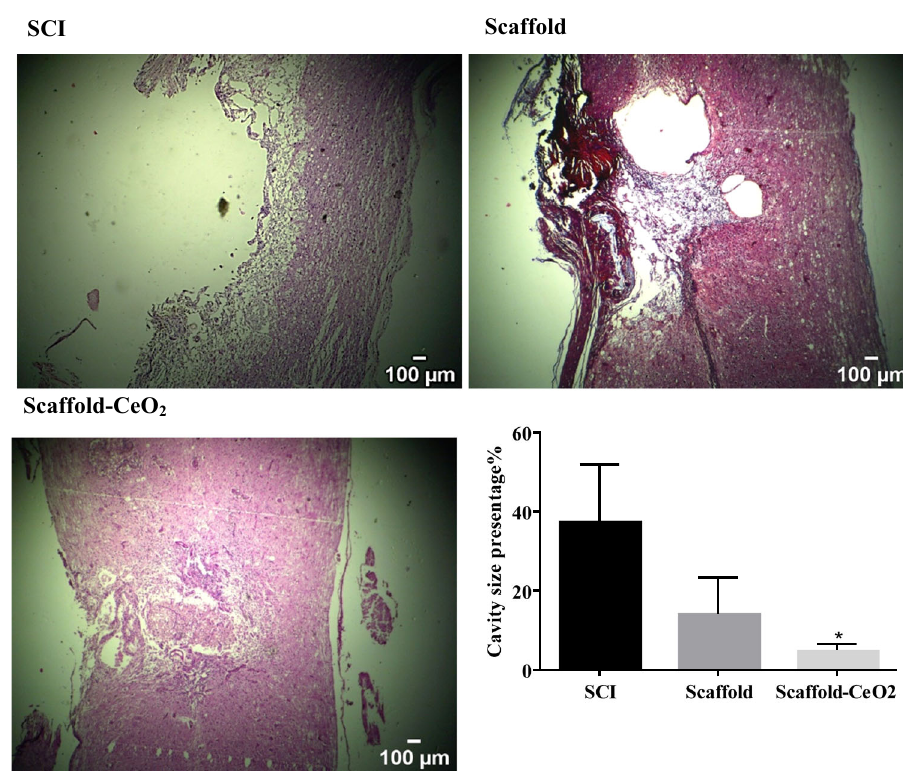
(H&E) staining for assessment of cavity size in the longitudinal sections of the spinal cord. The largest cavity was observed in the SCI group. Data are expressed as mean ± SD ( n = 3 in each group). Original magni fi cation ×4. * p <